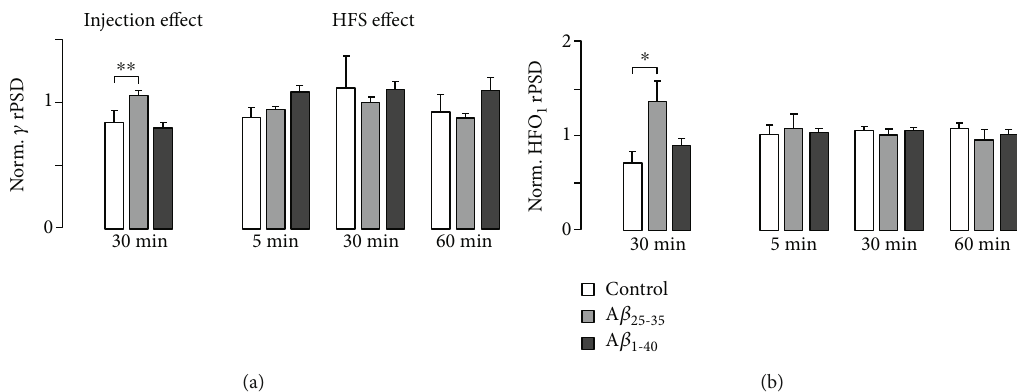
Figure 4: Peptide injection but not HFS increased rPSD in γ and HFO1 bands. Bar diagrams illustrating rPSD in γ (a) and HFO1 (b) bands. The left panel shows the e ff ect of peptide or vehicle, 30min after injection, normalized respecting baseline rPSD in the same bands. The right panel shows the e ff ect of HFS normalized regarding rPSD calculated after injection in the same bands. Bars and whiskers represent each group ’ s mean + SEM . ∗ Signi fi cant di ff erence respecting the control group during baseline ( p < 0 : 05 ); ∗∗ signi fi cant di ff erence respecting each group after peptide injection ( p < 0 : 01 ).